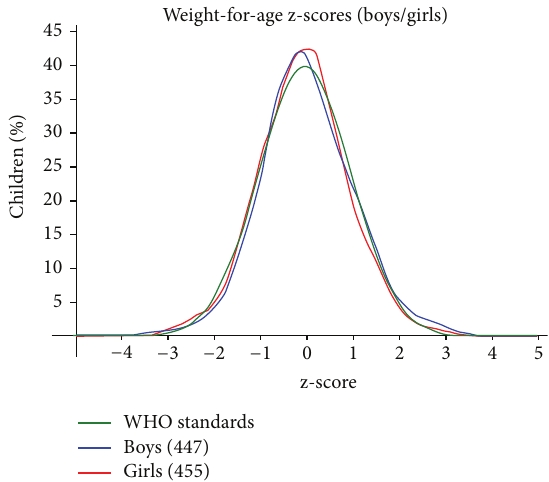
Figure 2: The graph of the normal distribution of weight for age in studied children in Salmas (mean ± SD = −0.01 ± 0.96